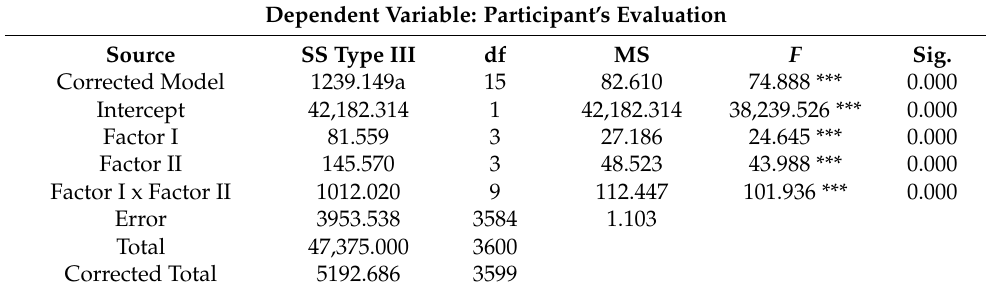
Table 6. Tests of between-participants